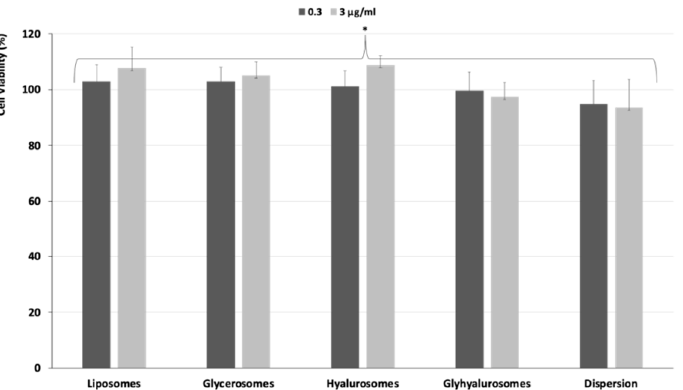
Figure 7. Viability of keratinocytes treated with Z. officinalis extract in dispersion or loaded in lipo-